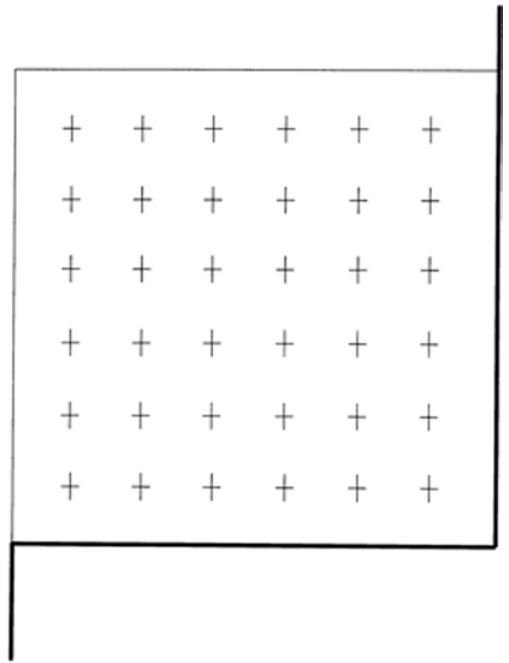
Fig. 12 –A test-system with 36 points. This system without lines allows fast counting and can be appropriated to majority of